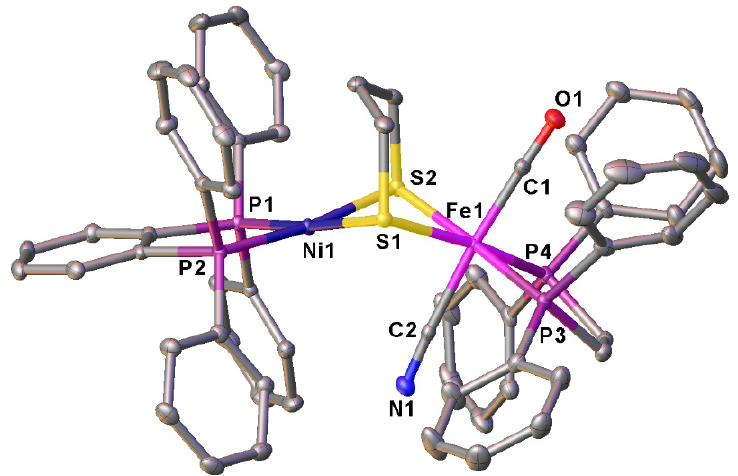
Figure 3. Molecular structure of [ 1 ]BF 4 with thermal ellipsoids drawn at a 30% probability level. All H atoms and one BF 4 − anion are omitted for the sake of clarity. Selected bond lengths (Å) and angles ( ° ): Ni ⋅⋅⋅⋅ Fe 3.2106, Ni1-S1 2.2500(8), Ni1-S2 2.2258(8), Fe1-S1 2.3360(8), Fe1-S2 2.3186(8), Fe1-P3 2.2226(8), Fe1-P4 2.2203(8), Ni1-P1 2.1667(8), C2-N1 1.144(4); S1-Ni1-S2 83.72(3), P1-Ni1-S1 173.76(3), P1-Ni1-P2 88.50(3), S1-Fe1-S2 79.84(3), P3-Fe1-S1 99.10(3), P3-Fe1-P4 86.13(3).